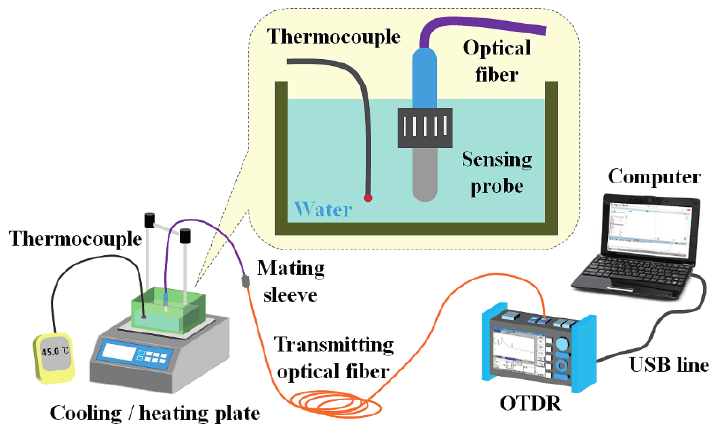
Figure 3. Composition of the fiber-optic temperature sensor to measure water